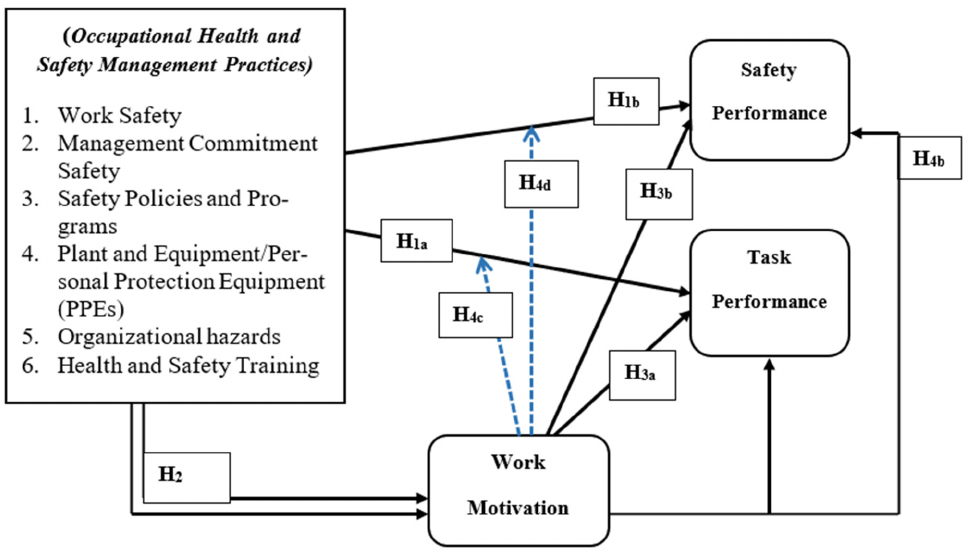
Figure 1. Conceptual